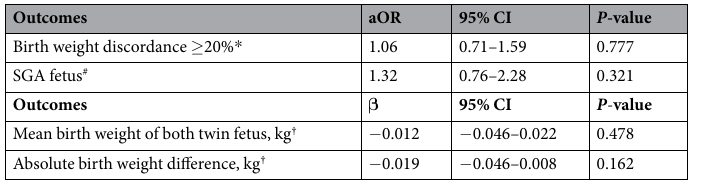
Table 3. The relationship between neonatal outcomes and placental location in multivariate adjusted models with different placental locations group as reference. Note: aOR, adjusted odds ratio; CI, confidence interval; SGA, small for gestational age. * Adjusted for neonatal sex, abnormal cord insertion and pre-gestational or gestational diabetes mellitus. # GEE model adjusted for neonatal sex, abnormal cord insertion and pre- gestational or gestational diabetes mellitus. † Adjusted for gestational age at delivery, neonatal sex, abnormal cord insertion and pre-gestational or gestational diabetes